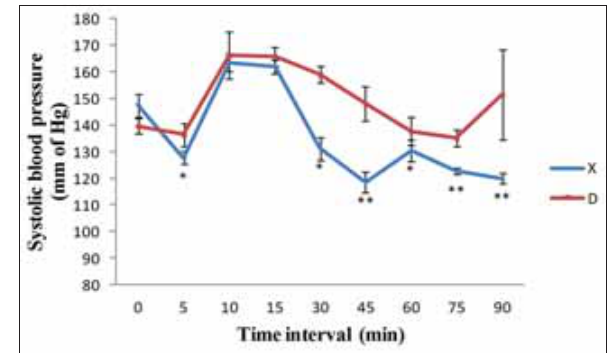
Figure-6: Mean±Standard error values of respiratory rate in animals of different groups. *Significantly different from the base value (p<0.05). **Significantly different from the base value (p<0.01).